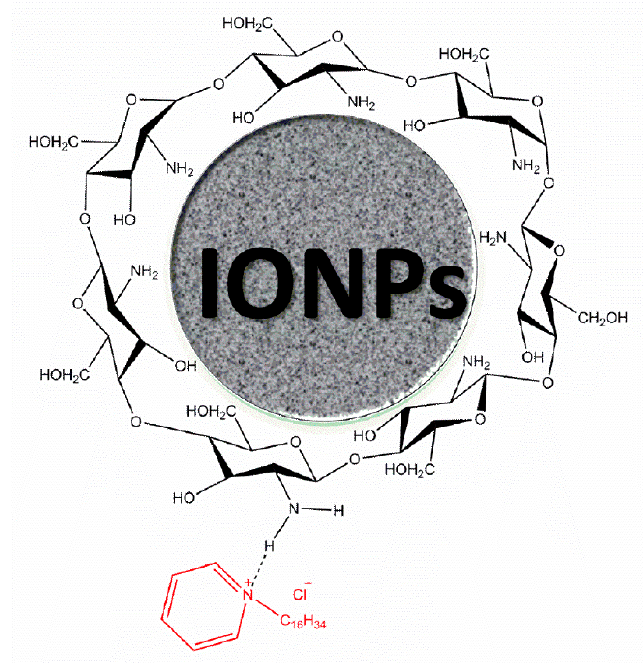
Figure 7. Schematic representation of the possible chemical bonds / interactions among the compounds that form the iron oxide nanoparticles-chitosan-cetylpyridinium chloride nanocarrier. A bond between oxygen from iron oxide nanoparticles (IONPs) and hydrogen from amine group (-NH 2 ) of chitosan (CS) is responsible for coating IONPs with CS. In turn, cetylpyridinium chloride (shown in red) establishes a hydrogen interaction with the amine group of CS.